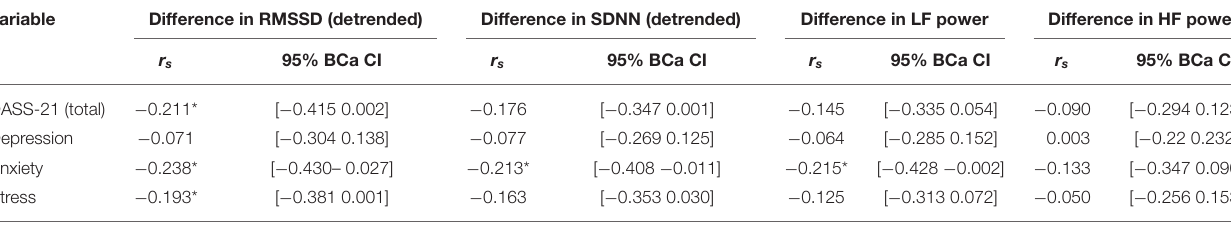
TABLE 5 | One-tailed spearman correlations between distress symptoms and differences in HRV between the HLC and LLC. Variable Difference in RMSSD (detrended) Difference in SDNN (detrended) Difference in LF power Difference in HF